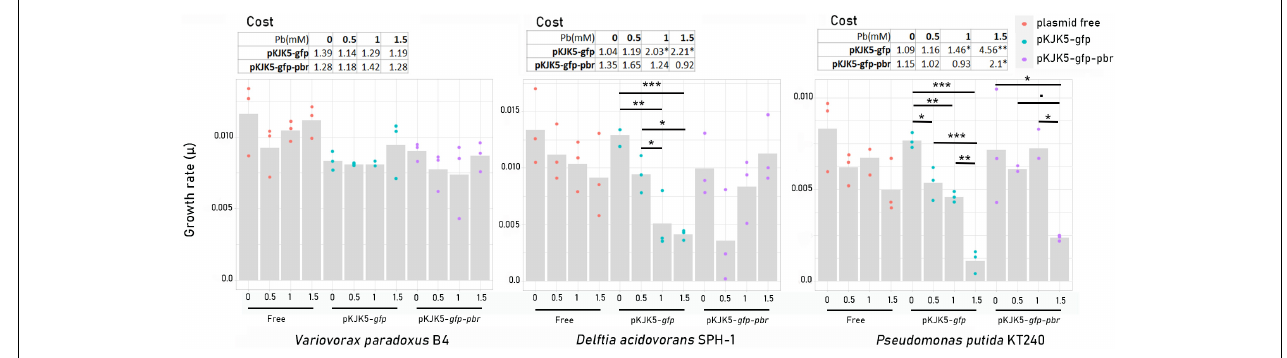
FIGURE 2 | Growth rates ( µ ) and plasmid fitness effect (cost, µ 0 / µ 1 ) ± SEM, where µ 0 = growth rate of the plasmid-free cells and µ 1 = growth rate of plasmid-carrying cells in pure cultures. The stars show significant differences among growth rates and the significance of the fitness effect (comparison between growth rates of the plasmid-carrying cells and plasmid-free cells at the same lead concentration). *p -value < 0.05; ** p -value < 0.01; *** p -value < 0.001 ( N = 3) ( n = 3; Tukey test; p ≤ 0.05).